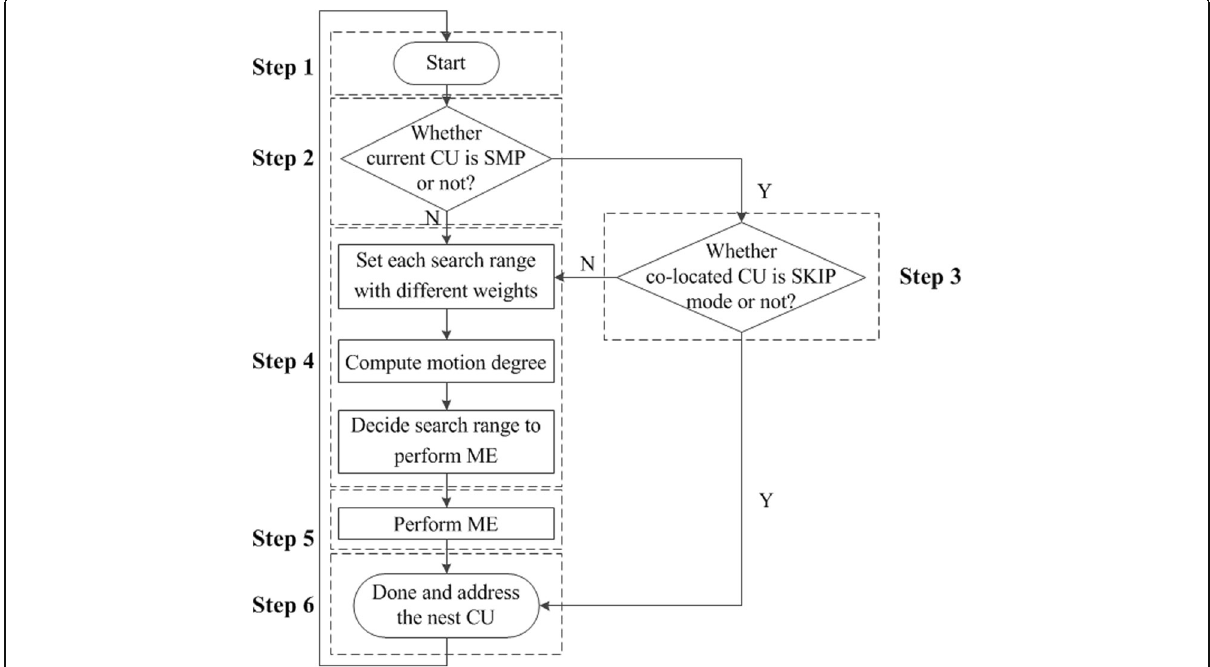
Fig. 5 Flow chart of our proposed overall algorithms